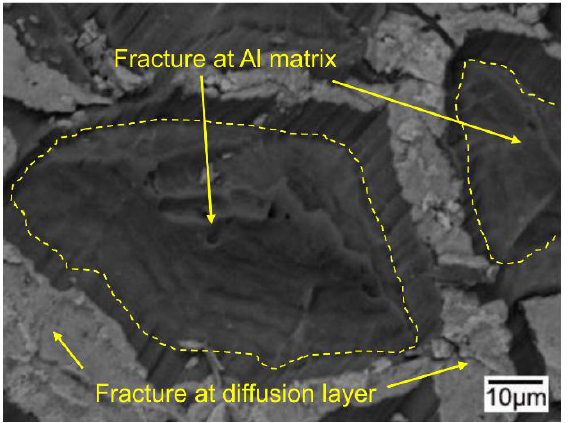
Figure 17. Peeled surface morphology (BSE image) of the Cu/Al clad sheet with a thickness of 3 mm after multi-pass rolling and annealing (Al side).